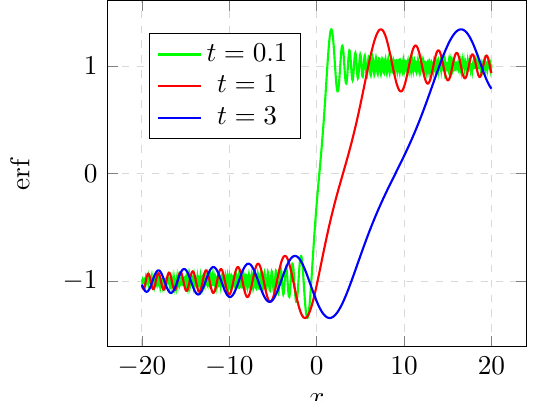
(cid:128) ( i + 1 )( x − gt ) (cid:138) (cid:112) , at g = 3, for different times t 2